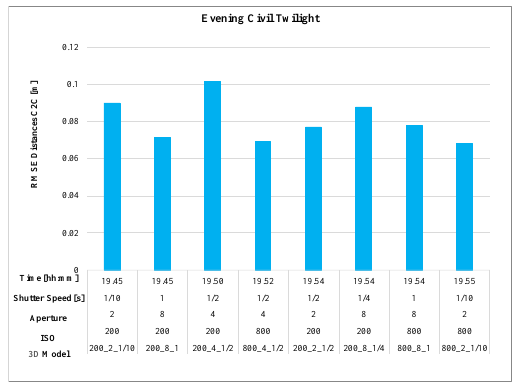
Figure 3 – RMSE of the absolute distances for the photogrammetric models computed with the C2C method during the evening civil twilight.